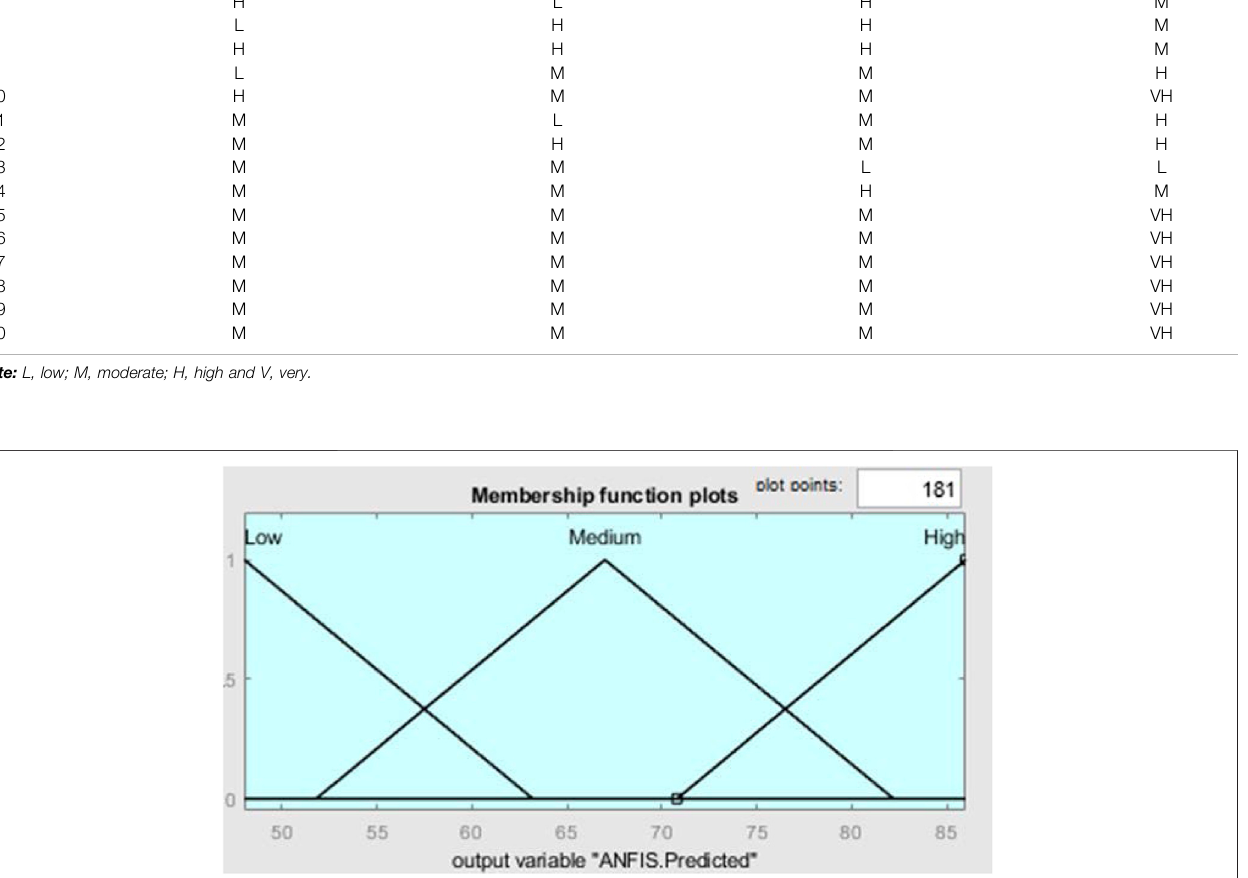
TABLE 4 | ANN training